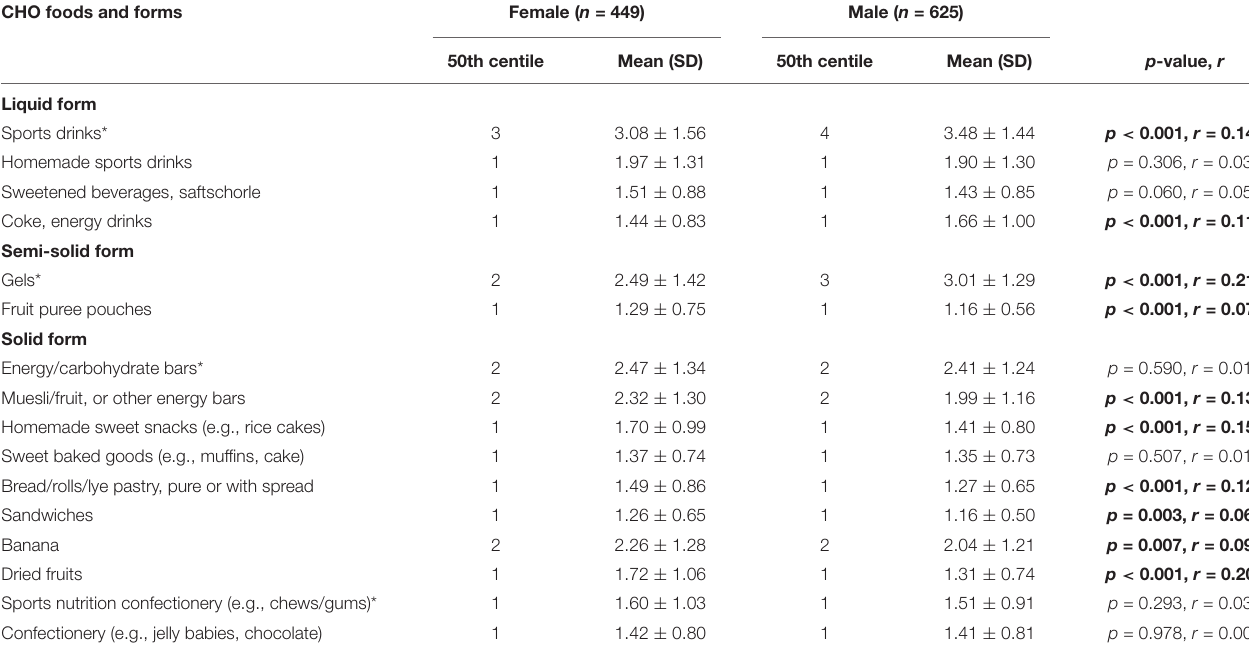
TABLE 4 | Sex-based differences in intake frequencies of carbohydrate foods during training at high exercise intensities. CHO foods and